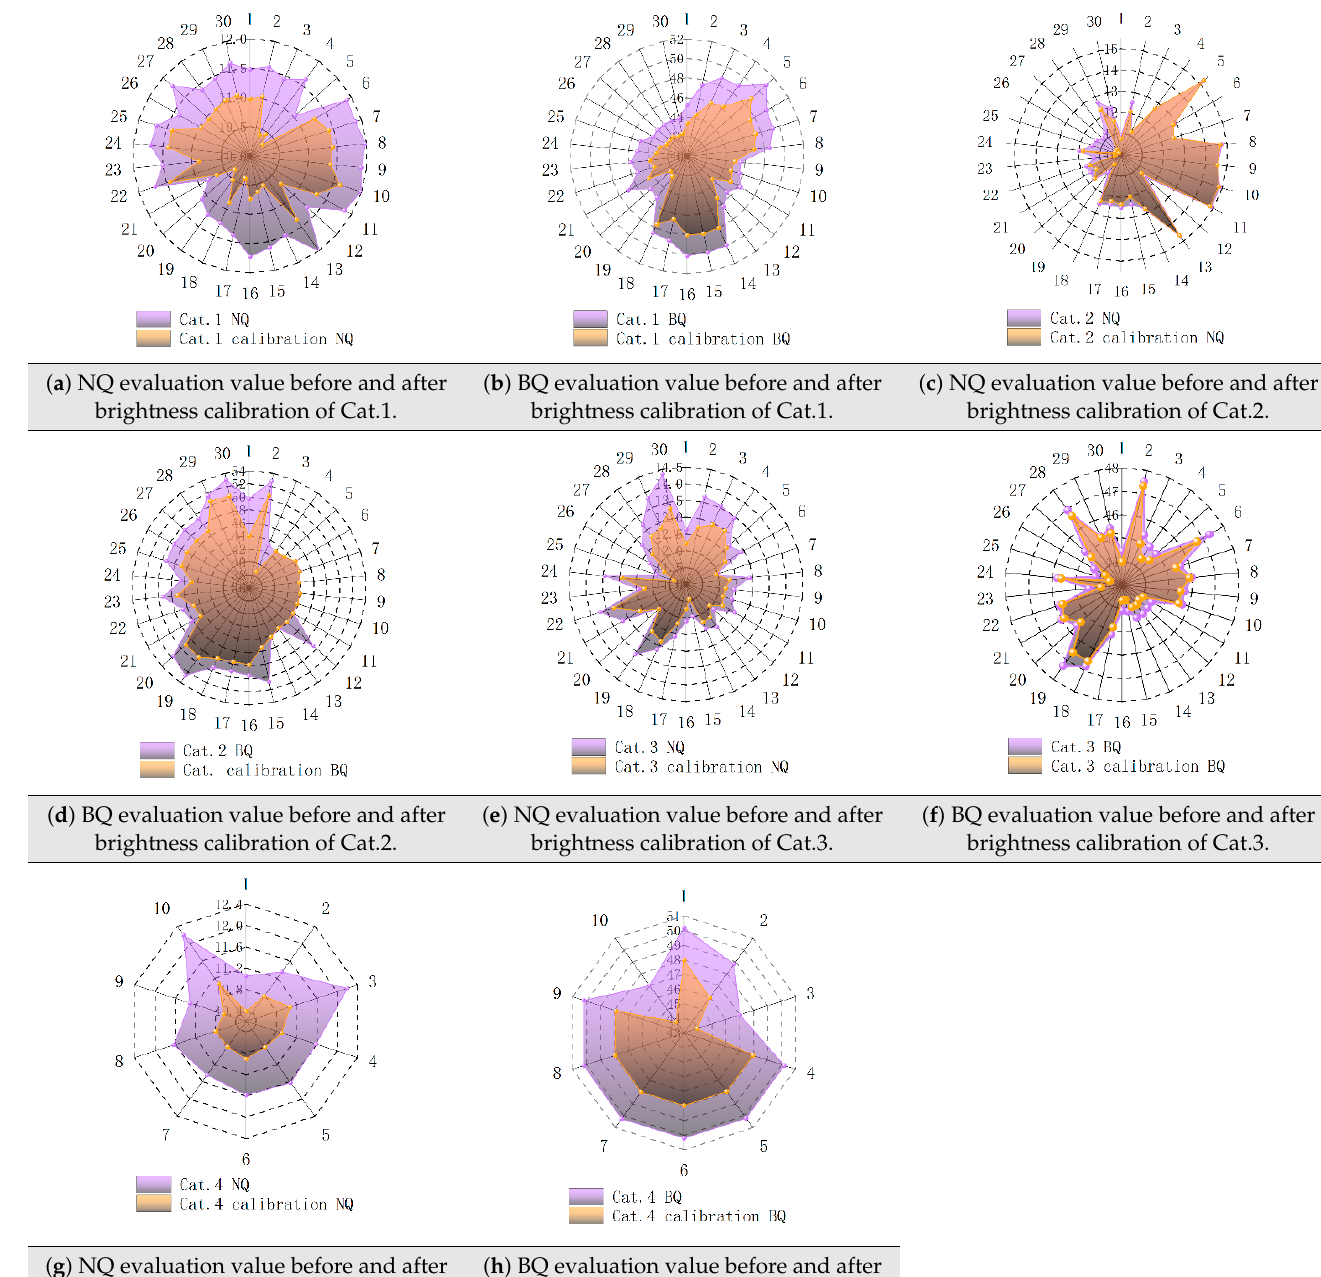
Figure 10. Comparison of brightness calibration for four categories of wafer images. ( a ) The wafer image of Cat.1_7; ( b ) the wafer image of Cat.3_7; ( c ) the wafer image of Cat.2_7; ( d ) the wafer image of Cat.4_1; ( e ) the result of brightness calibration on ( a ); ( f ) the result of brightness calibration on ( b ); ( g ) the result of brightness calibration on ( c ); ( h ) the result of brightness calibration on ( d ); ( i ) the grayscale distribution map of ( a ); ( j ) the grayscale distribution map of ( b ); ( k ) the grayscale dis- tribution map of ( c ); ( l ) the grayscale distribution map of ( d ); ( m ) the grayscale distribution map of ( e ); ( n ) the grayscale distribution map of ( f ); ( o ) the grayscale distribution map of ( g ); ( p ) the gray- scale distribution map of ( h ). Table 4. The quality evaluation results of NQ and BQ before and after the brightness calibration for four categories of wafer images.